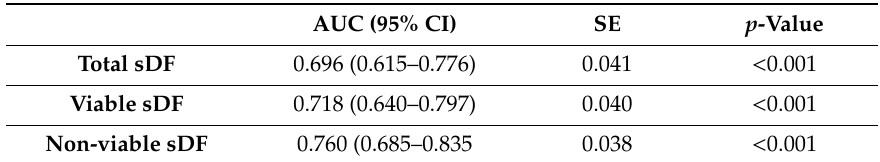
Table 3. Area under the curve values of total, viable, and non-viable sDF for prediction model for fertile versus subfertile